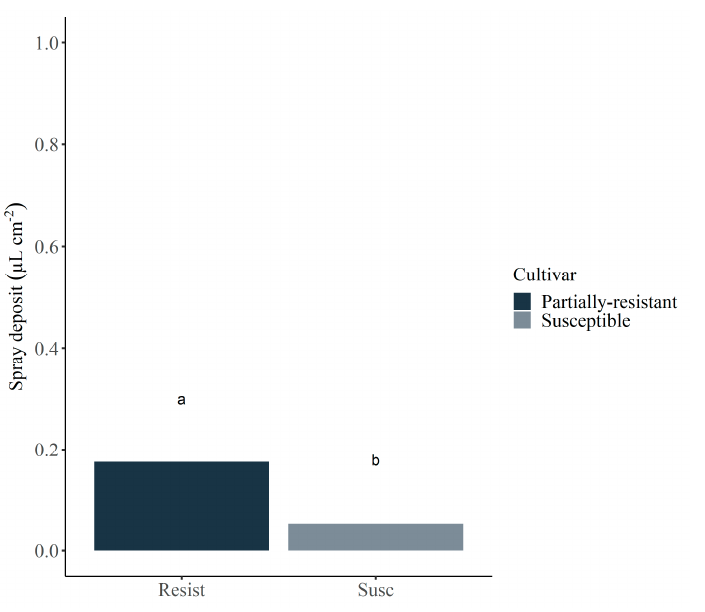
Figure 7. Mean deposit values ( µ L cm − 2 ) that were collected in the lower region of the soybean canopy of different soybean cultivars in the second application of Field 1. The means followed by the same letter did not differ by the Tukey’s test at 5% probability ( p <